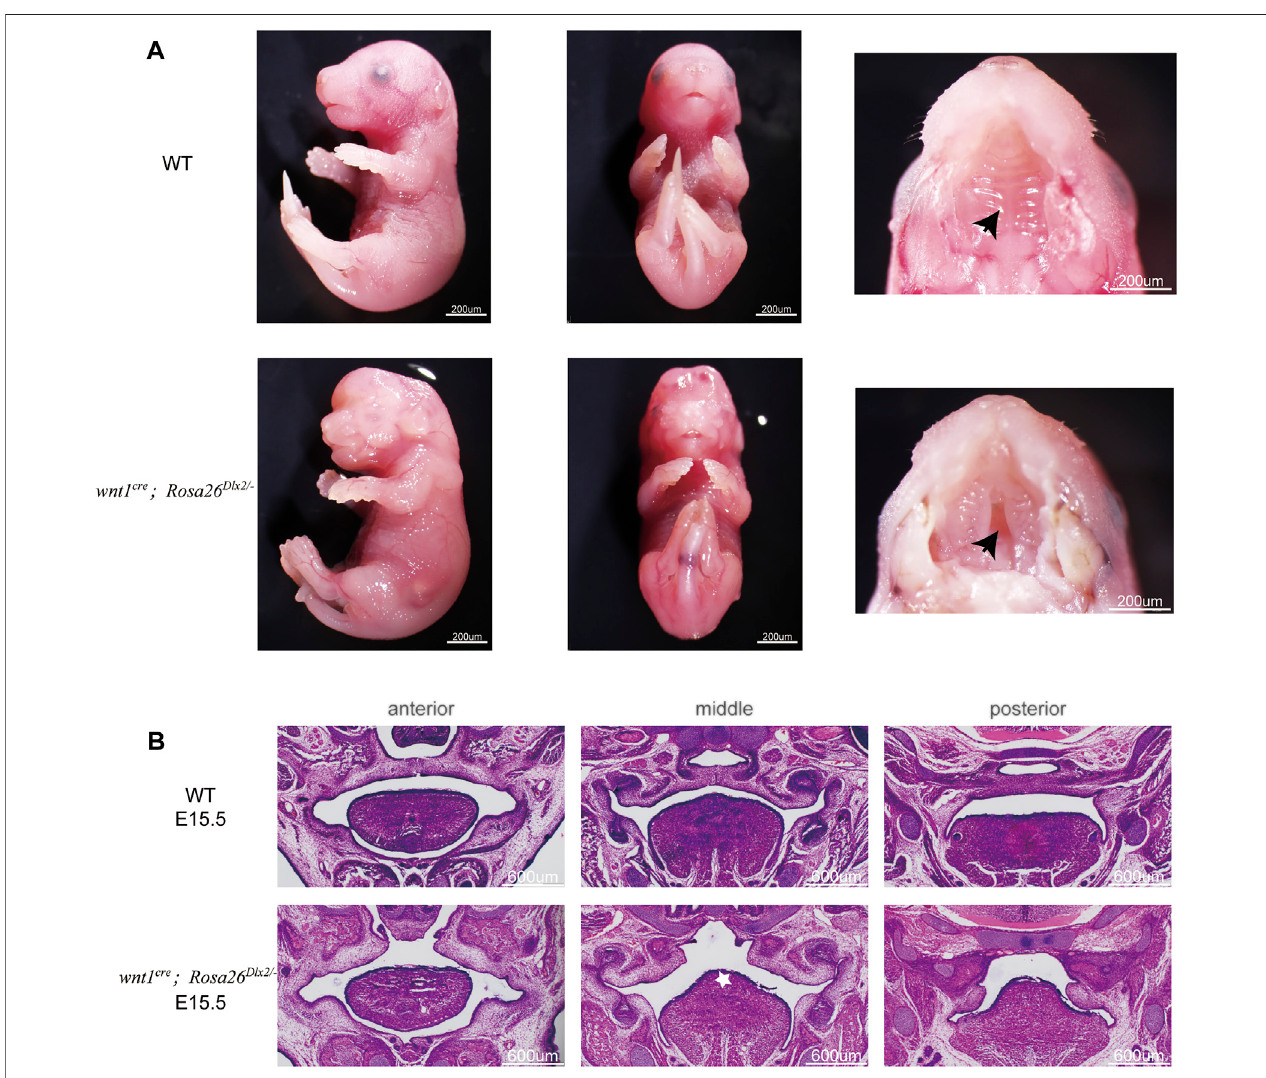
FIGURE4| Phenotypeof wnt1 cre ;Rosa26 Dlx2/- miceatE15.5 (A) Stereomicroscopeimagesshowingthecleft(blackarrow)inthepalateatE15.5 (B) HEstainingof frontalsectionsshowingthemorphologyofmaxillaryprocessesofWTand wnt1 cre ;Rosa26 Dlx2/- mouseembryosatE15.5. Wnt1 cre ;Rosa26 Dlx2/- embryosdisplayacleft in the palate. White star indicates the towering